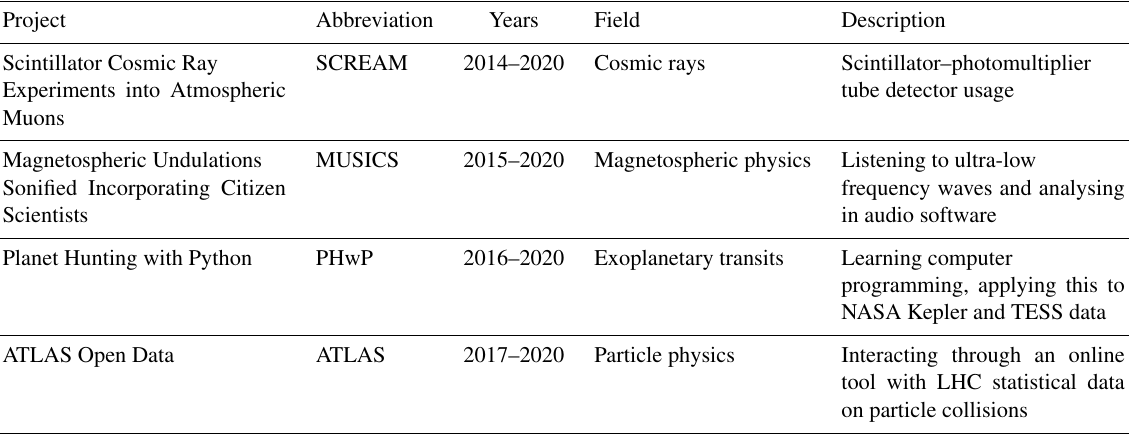
Table 1. A summary of the existing PRiSE projects at QMUL.